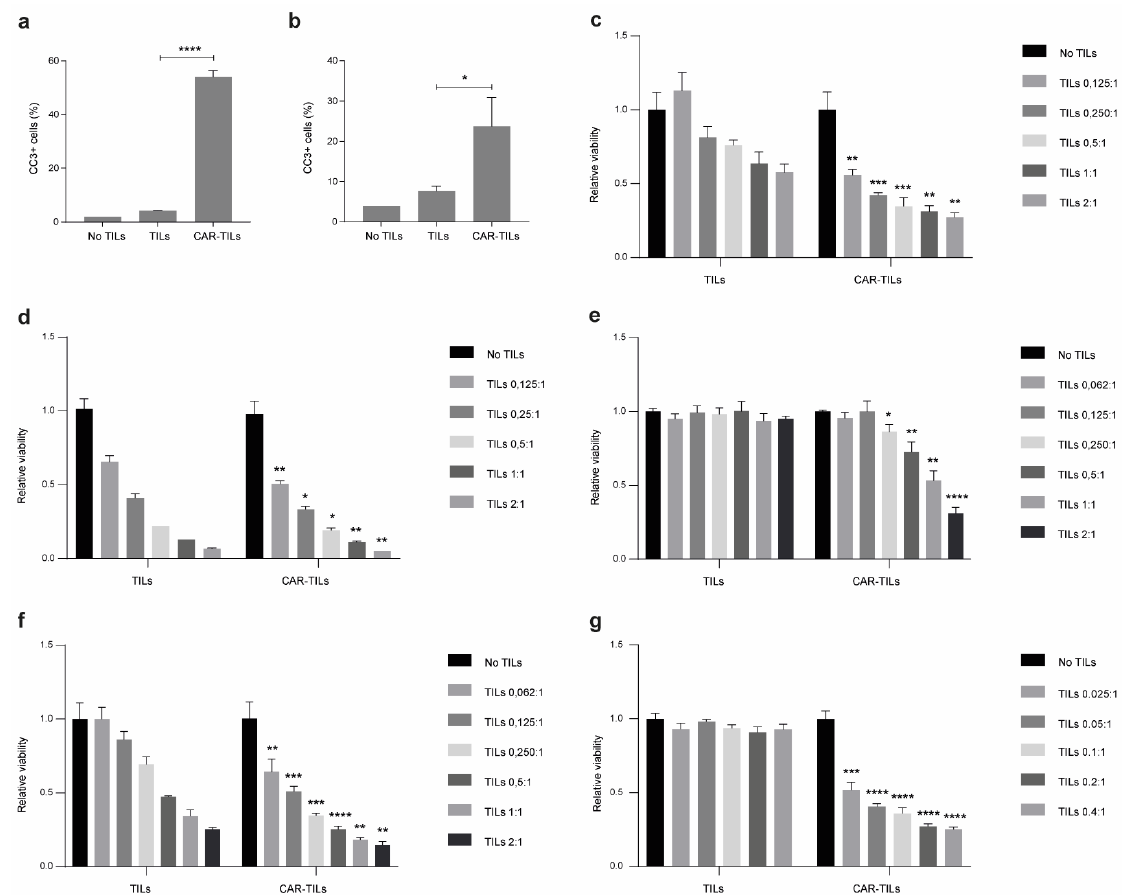
Figure 2. CAR-TILs kill tumor cells more efficiently than TILs. ( a , b ) TILs and CAR-TILs from MM1 were co-cultured with the parental or HER2 KO 92-1 uveal melanoma cell line for 24 h, followed by cleaved caspase 3 (CC3) detection in the tumor cells using flow cytometry ( a ). Additionally, TILs and CAR-TILs from MM5 were co-cultured with autologous cancer cells for 24 h, followed by cleaved CC3 detection using flow cytometry ( b ). Cancer cells not treated with TILs were used as a control (no TILs). ( c – g ) Viability of autologous cancer cells was measured by luciferase signal detected after 48 h co-culture with increasing doses of TILs and CAR-TILs from UM22 ( c ), MM3 ( d ), MM4 ( e ), MM5 ( f ), and MM6 ( g ) in the indicated ratios (TILs:cancer cells). Data are presented as mean with SD of triplicates. Asterisks represent p -values of difference between similar doses of TILs and CAR-TILs. The experiments were performed twice, and representative data from one experiment is